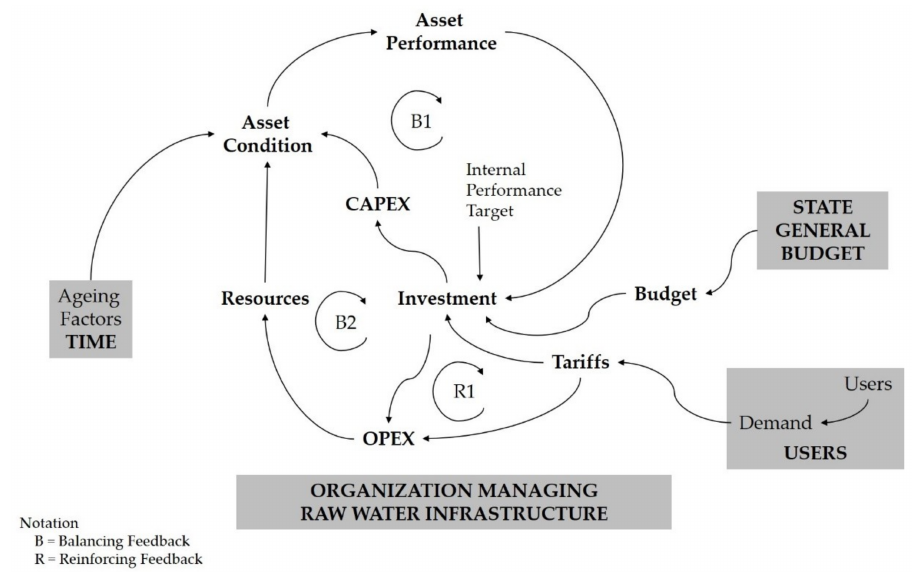
Figure 1. Causal loop diagram (adapted from Schneider at al.